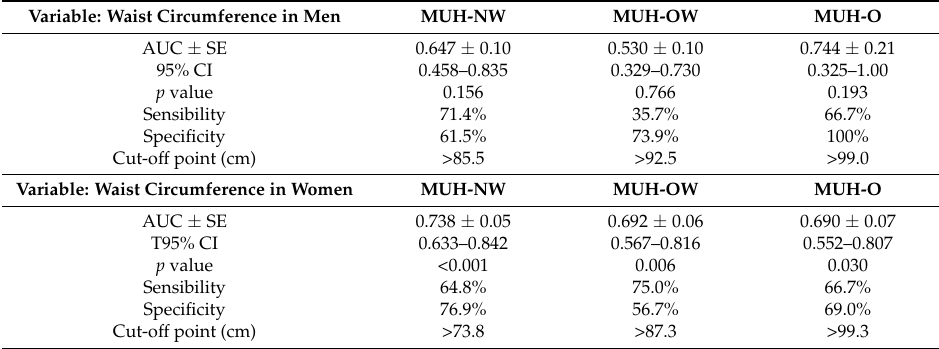
Table 2. ROC curve for detecting the metabolically unhealthy phenotype in men and women with normal-weight, overweight, and obesity.